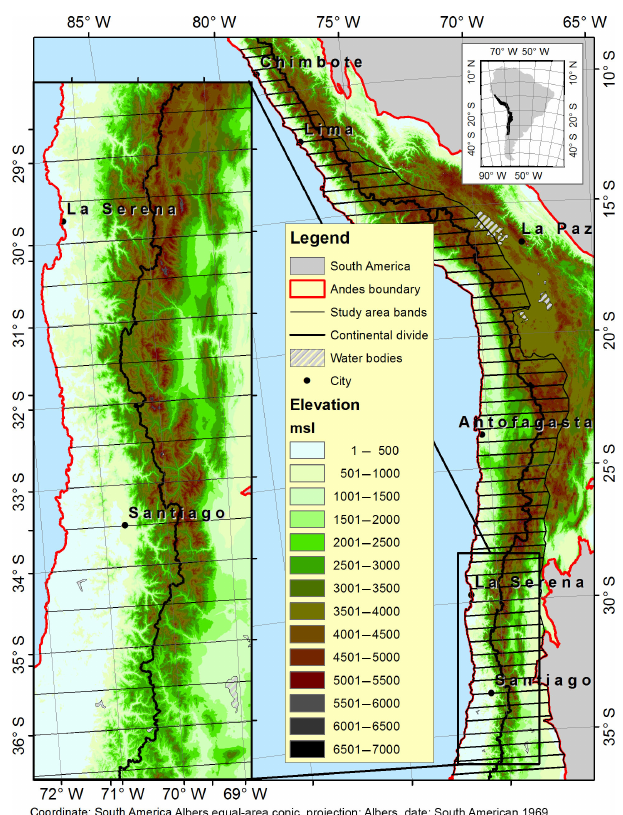
Figure 1. Study area (red line) over digital elevation model of the Central Andes subdivided into 0.5 ◦ latitude bands (black lines). The zoomed-in image highlights the area with more